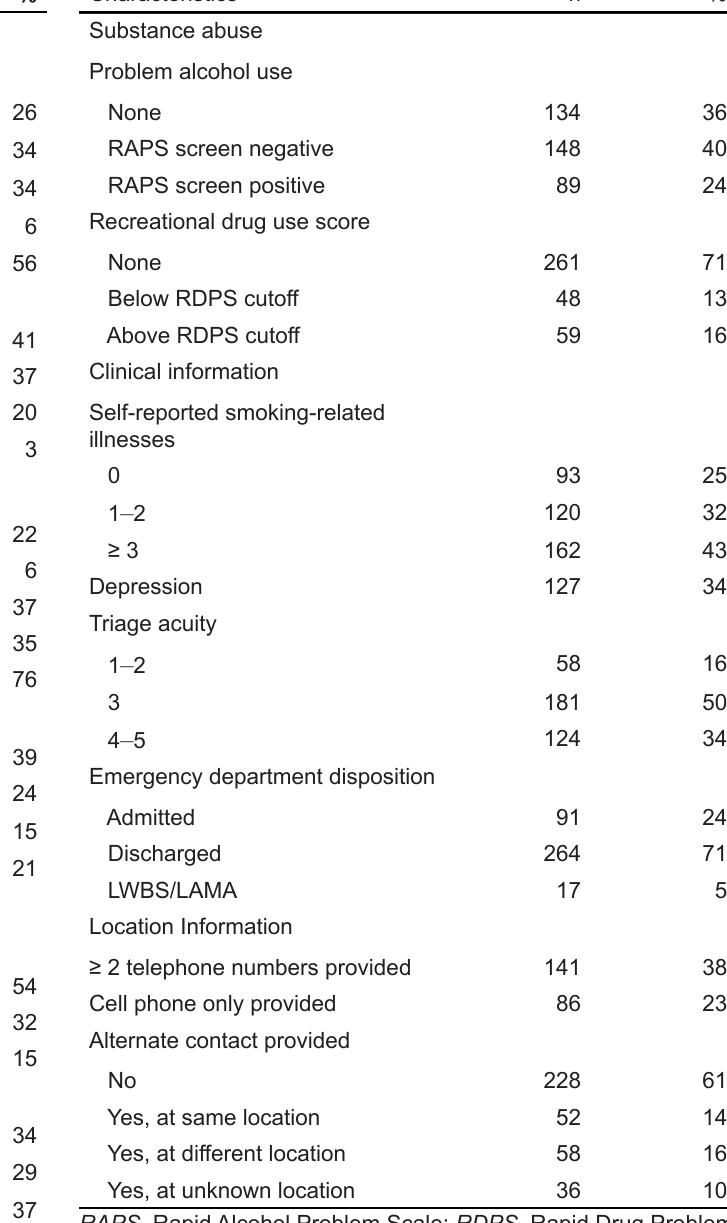
Table 1. Baseline characteristics of 375 enrolled